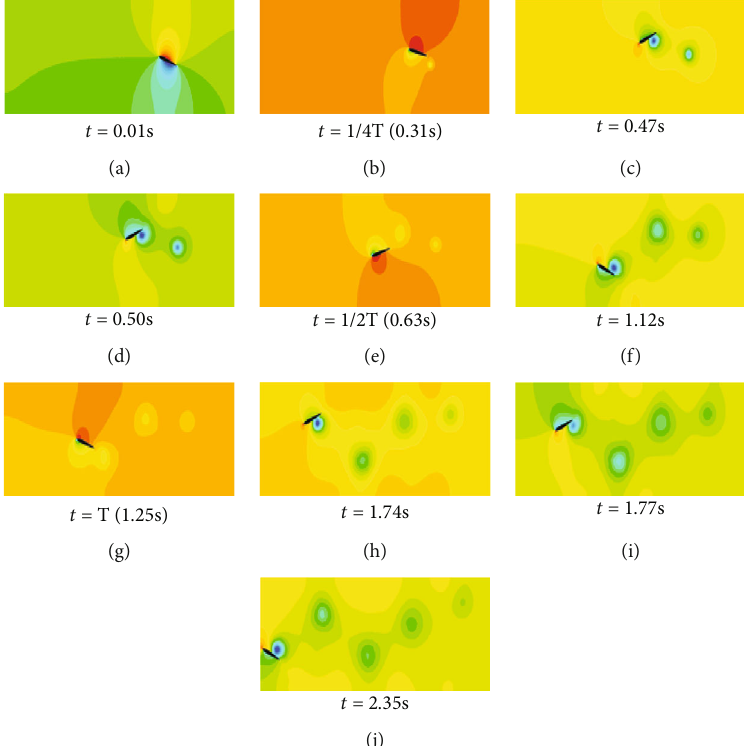
Figure 5: The fl uid pressure distribution of the fl uctuation caudal fi n at di ff erent times.